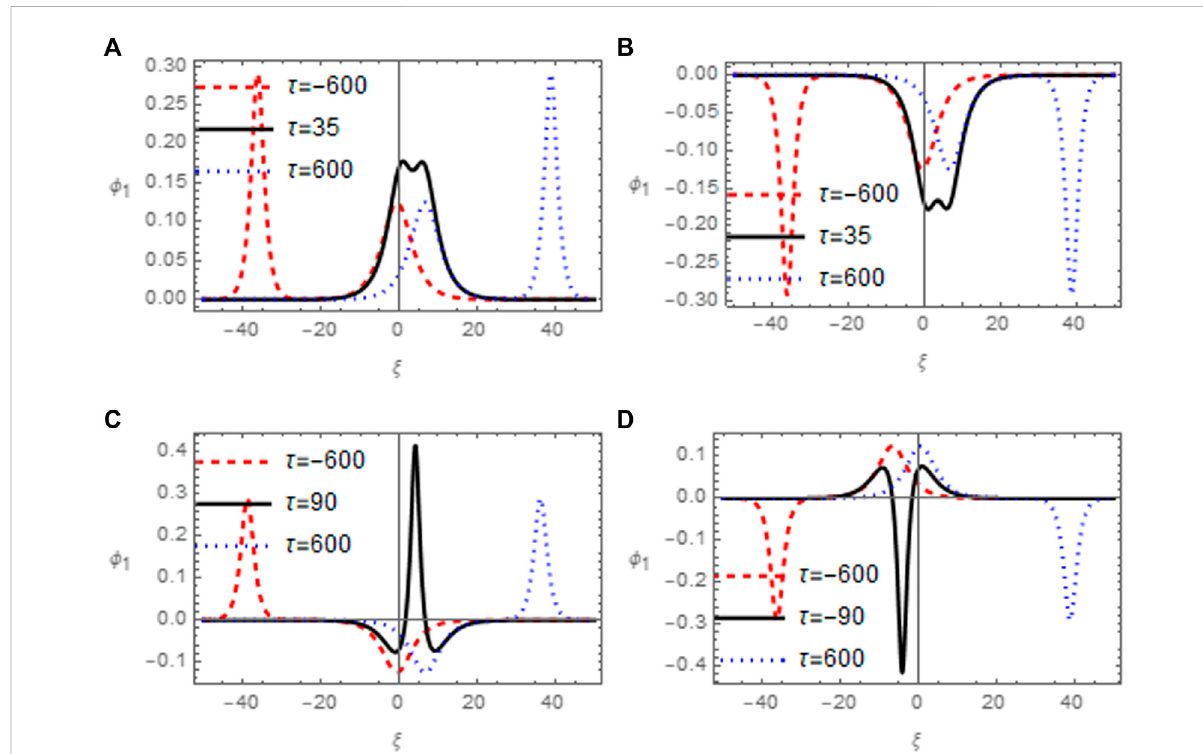
Variation of normalized electric potential Ψ ( ξ , τ ) of two soliton solutions is plotted against the normalized scale ξ . (A) ; Interaction of two compressive solitons (B) ; Interaction of two rarefactive solitons (C) ; Interaction of taller compressive with shorter rarefactive soliton (D) ; Interaction ofshortercompressivewithtallerrarefactivesoliton.Here q =2.5, r =0.4, n h 0 =2 cm − 3 , n c 0 =0.5 cm − 3 ,. n b 0 =1 cm − 3 , σ c =0.001, σ b =0.01and v b 0